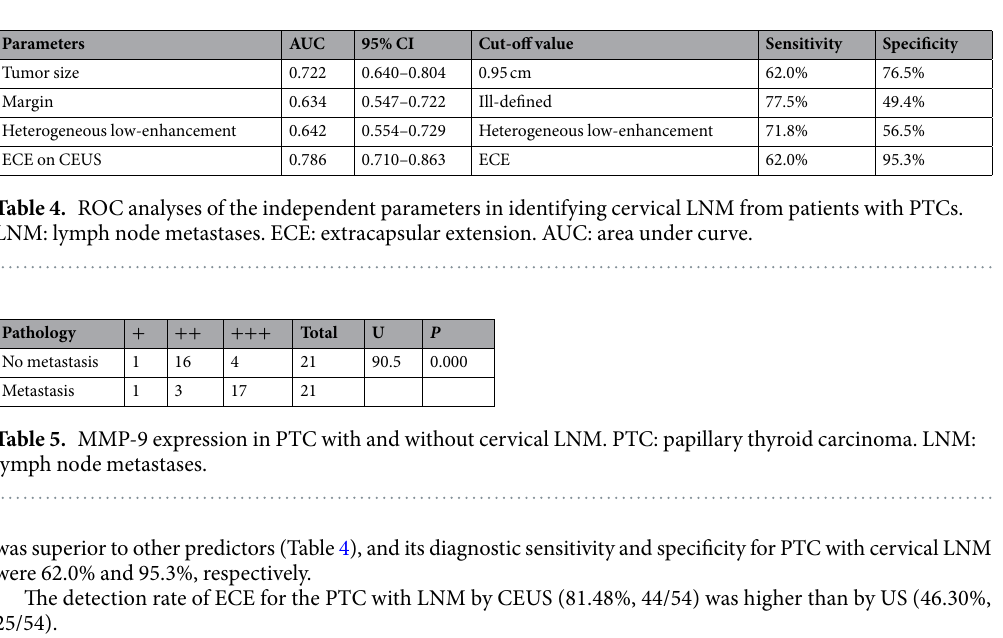
Table 3. Multivariate analysis of association of cervical LNM and ultrasonographic characteristics. LNM: lymph node metastases. ECE: extracapsular extension.